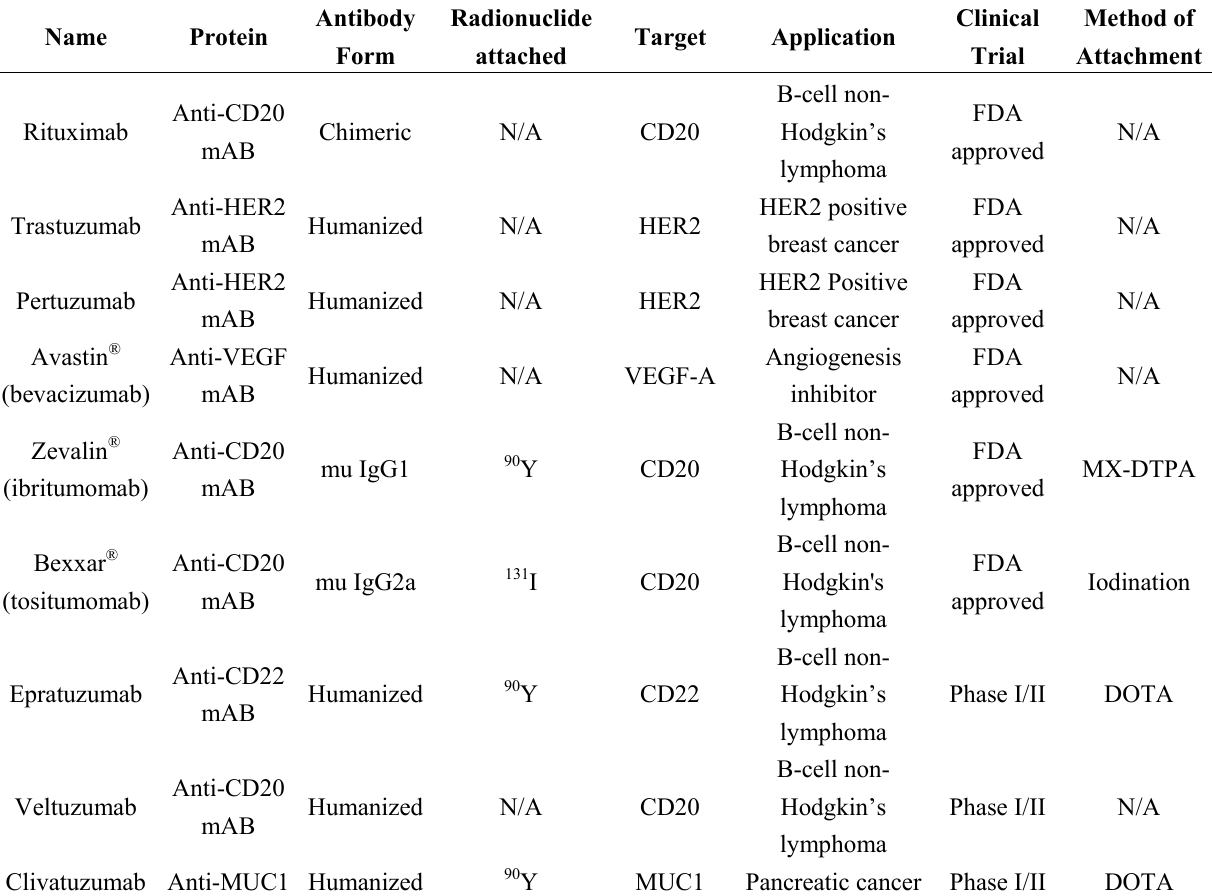
Table 3. A selection of clinically used/trialed antibody based drugs, their targets and, if applicable, method of radiolabel